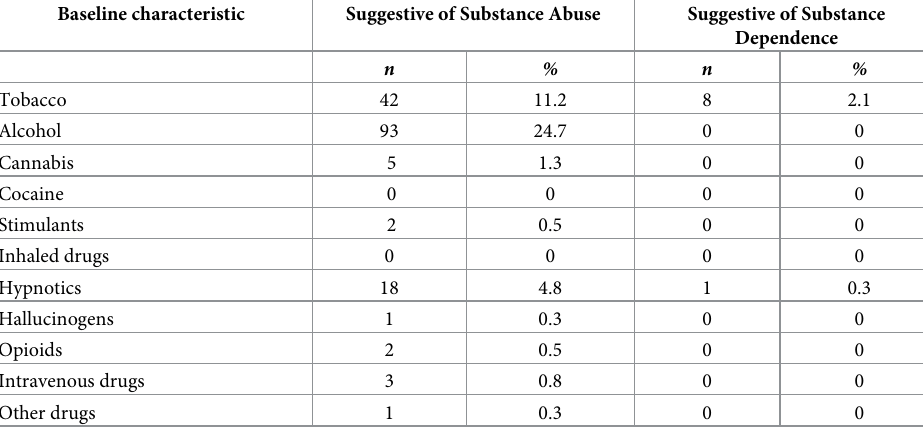
Table 5. Prevalence of substance use according to the ASSIST 2.0 categories.